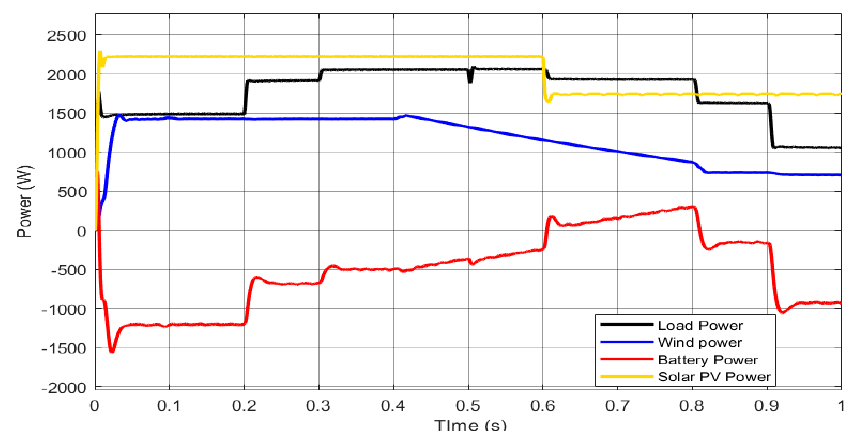
Figure 10. V&I at point of common coupling (PCC). Figure 11. Modulation index waveform.